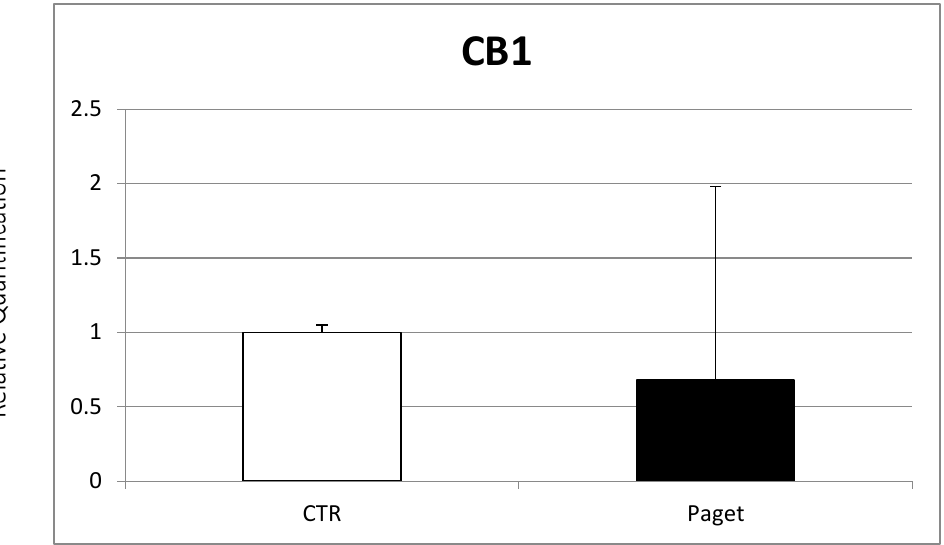
Figure 2. Comparison between CB1 mRNA expression evaluated with RT-PCR from 2 OCs of subjects with PDB and 2 healthy controls. Results were normalized for the housekeeping gene β -Actin and were showed as mean ± SD of three independent experiments on each individual sample .